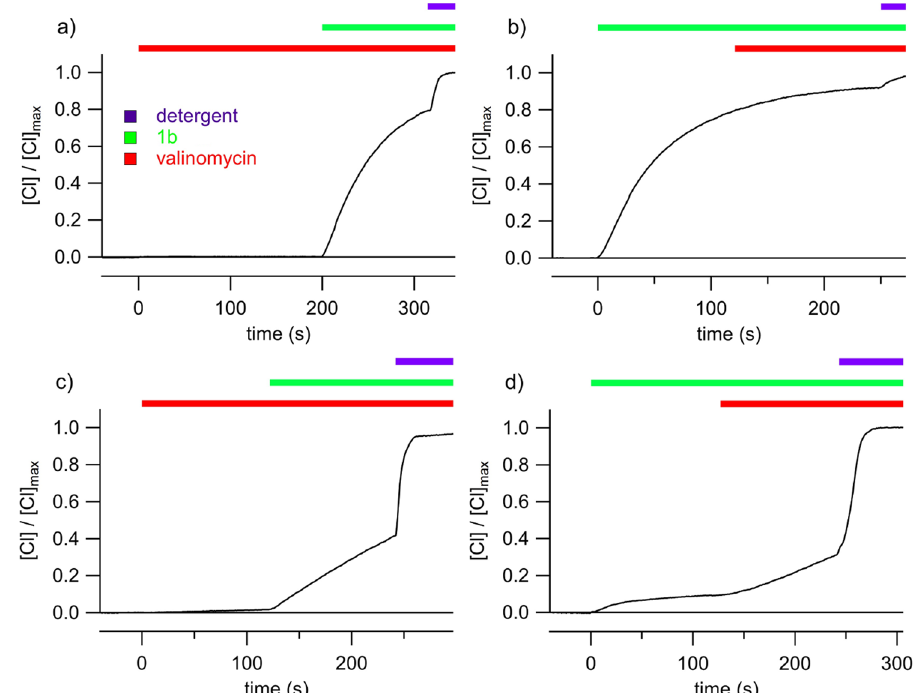
Figure 5. Chloride transport in valinomycin-“shunted” membranes. Chloride efflux induced by the anionophore 1b (4 µ M) recorded in LUVs with 450 mM KNO 3 and 20 mM HEPES, pH 7.0 in the external solution ( a and b ), and with 300 mM K 2 SO 4 and 20 mM HEPES, pH 7.0 in the external solution ( c and d) . The LUV contained 450 mM KCl and 20 mM HEPES, pH 7.0. ( a ) Addition of valinomycin (1 µ g/ml) does not induce any chloride efflux, and successive application of the anionophore induced a consistent chloride efflux. ( b ) When valinomycin is added after 1b induced chloride efflux is initiated, it does not modify the time course of the transport. ( c ) In the presence of the external impermeable anion, a robust chloride efflux is observed when the anionophore 1b is applied in presence of valinomycin. ( d ) The anionophore elicits a very